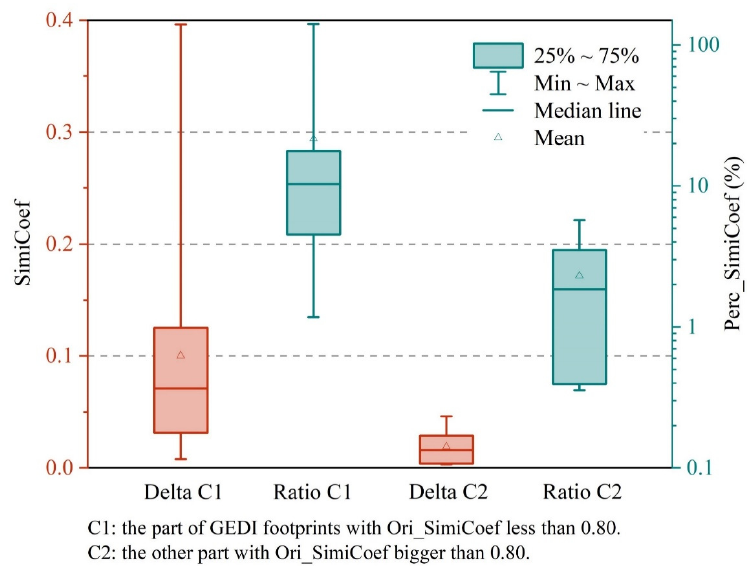
Figure 5. The effect of SimiCoef (R) increasing after geolocation error correction in two GEDI sets (triangle is the mean value). C1 is the part of the GEDI footprints with Ori_SimiCoef less than 0.80 while C2 is the other part. Delta = Cor_SimiCoef-Ori_SimiCoef; Ratio = Delta/Ori_SimiCoef. Note that the vertical scale on the right has logarithmic distribution. Table 5. Waveform similarity coefficient (R) around orbit quality and data